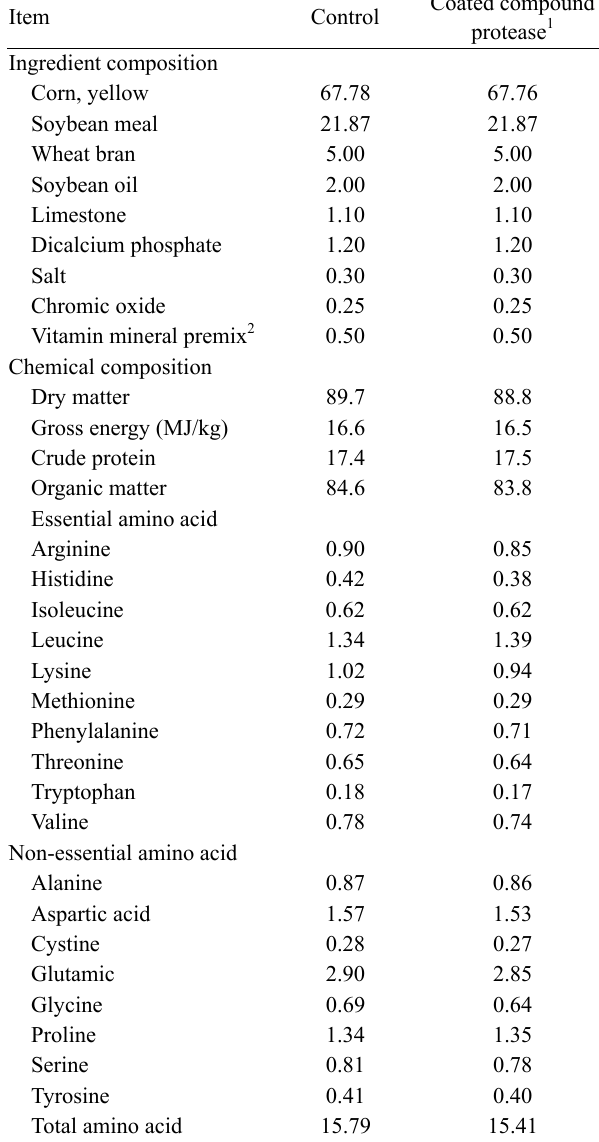
Table 1. Ingredient and chemical composition of the experimental diets (%; as-fed